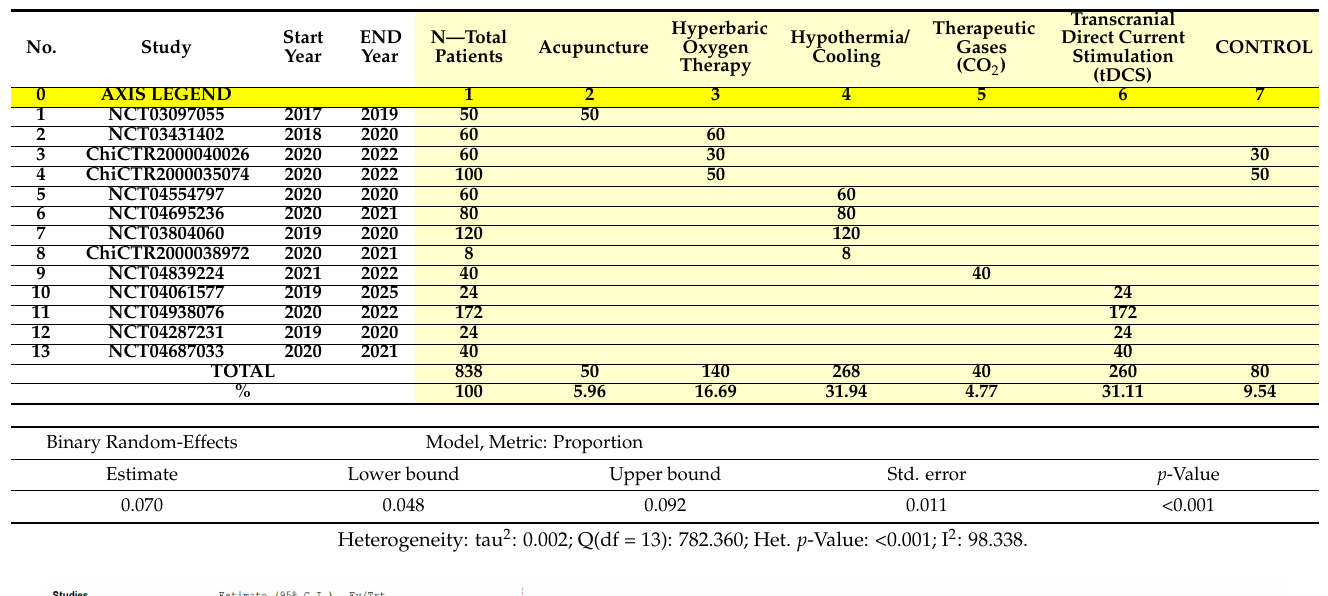
Table 1. The clinical trials that satisfied all the previous filtering criteria/PRISMA stages selected for qualitative synthesis were included in our meta-analysis to determine the frequency with which non-invasive, non-pharmacological interventions were used for acute ischemic stroke.